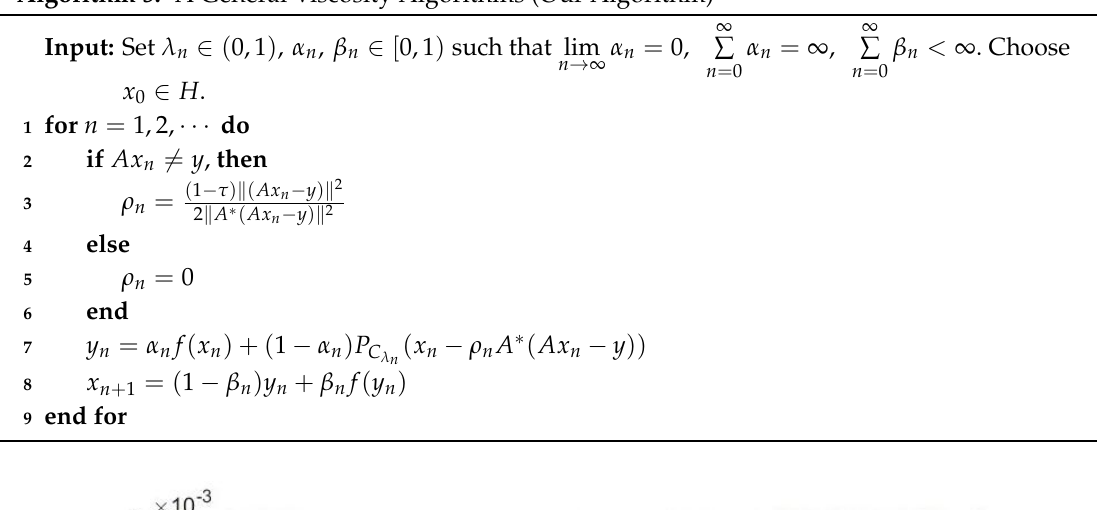
Algorithm 5: A General Viscosity Algorithms (Our Algorithm)